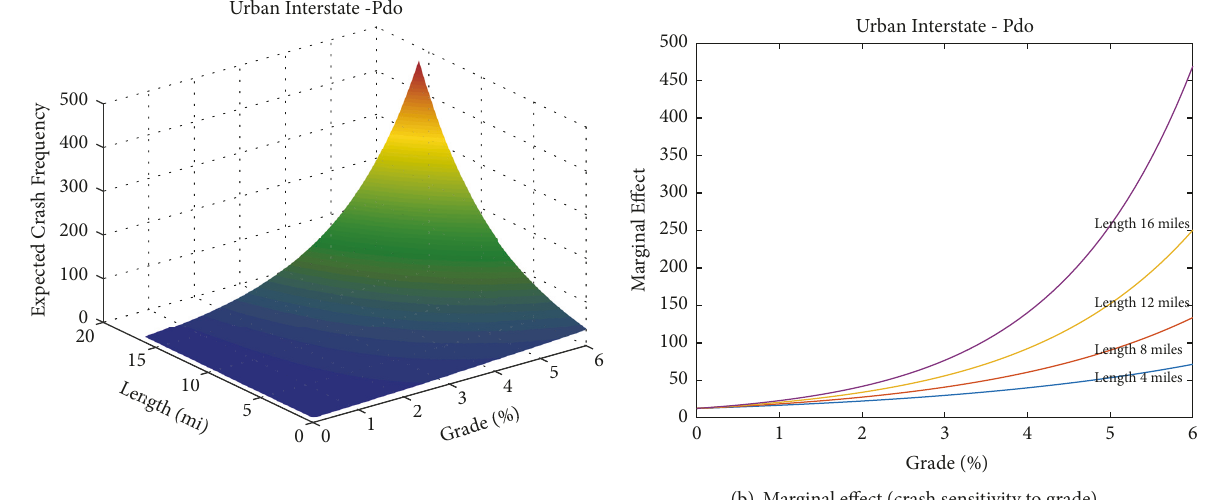
Figure 6: Urban interstate PDO crashes.